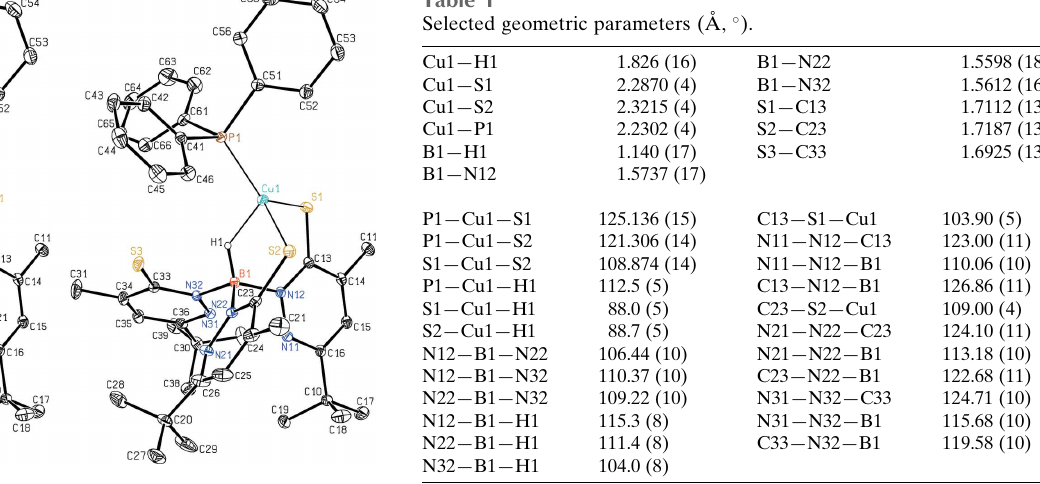
Figure 1 Stereoscopic plot of the molecular structure of the title compound, with the atom labelling and displacement ellipsoids drawn at the 50% probability level. Atom H1 is drawn with an arbitrary radius, the other H atoms as well as the less occupied orientation [39.3 (4)%] of the disordered tert -butyl group and the solvent molecules have been omitted for clarity.